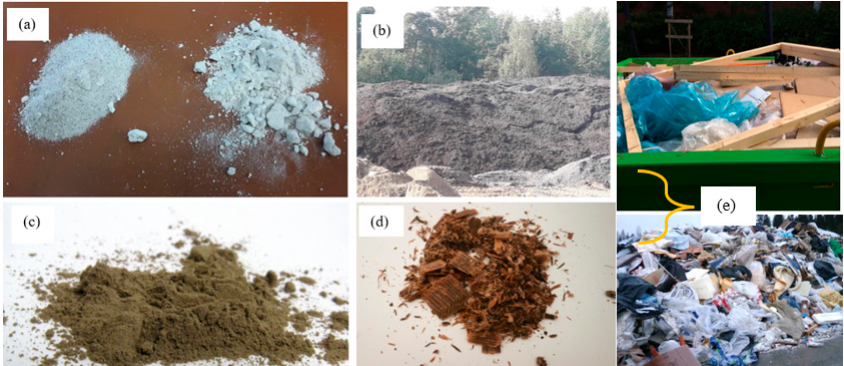
Figure 1. Industrial waste side streams used in this study: ( a ) fine and coarse fraction of flotation sand; ( b ) green liquor sludge; ( c ) paper mill power plant ash; ( d ) fiber waste; ( e ) mixed composition of materials in CDW. Table 1. Compositions of the construction